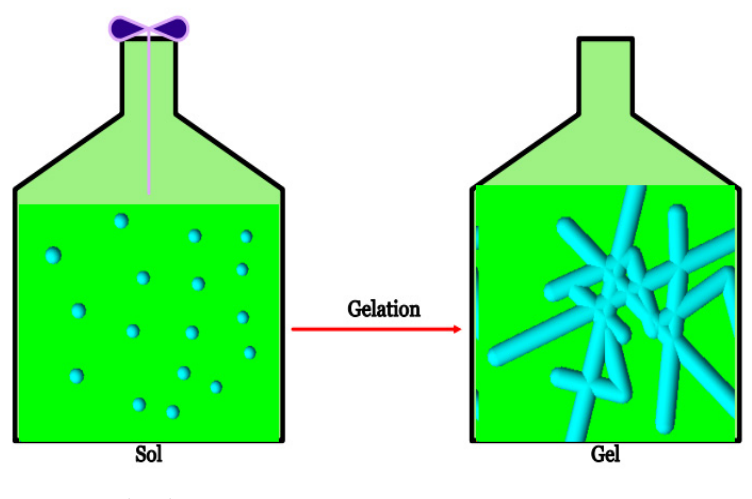
Figure 5. Sol–gel transition.